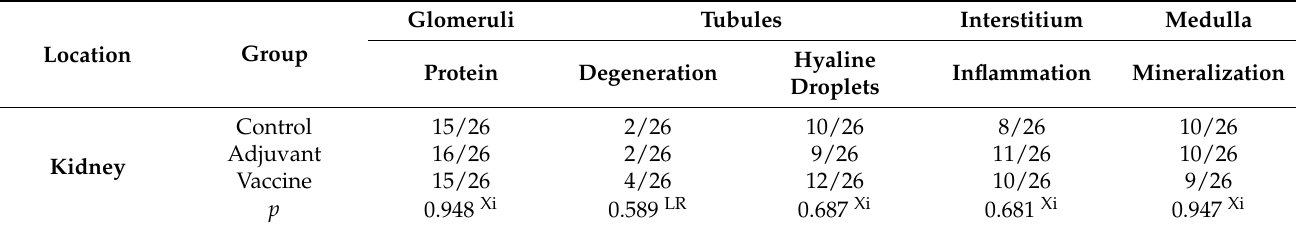
Table A17. Histopathological findings in the kidney.